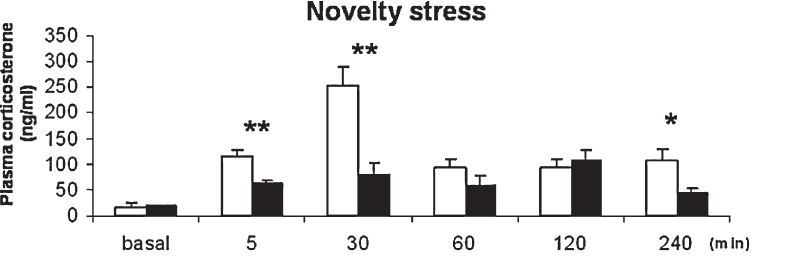
Figure 2. Corticosterone concentrations in ng/ml, basal resting and novelty-induced responses at 5, 30, 60, 120, and 240 minutes of novel cage exposure. BALB/c: white bars; C57BL/6J: black bars *p < 0.05, **p (cid:4) 0.001.